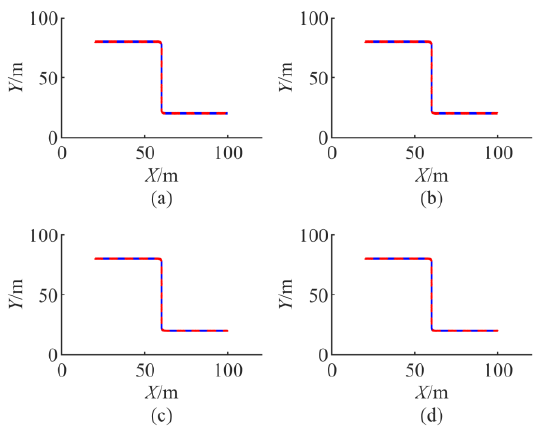
Figure 27. The trajectory with the positioning error in ±0.1m. The red line is the trajectory. The blue line is the reference path. ( a ) LMPC. ( b ) LEMPC. ( c ) NMPC. ( d ) NEMPC.